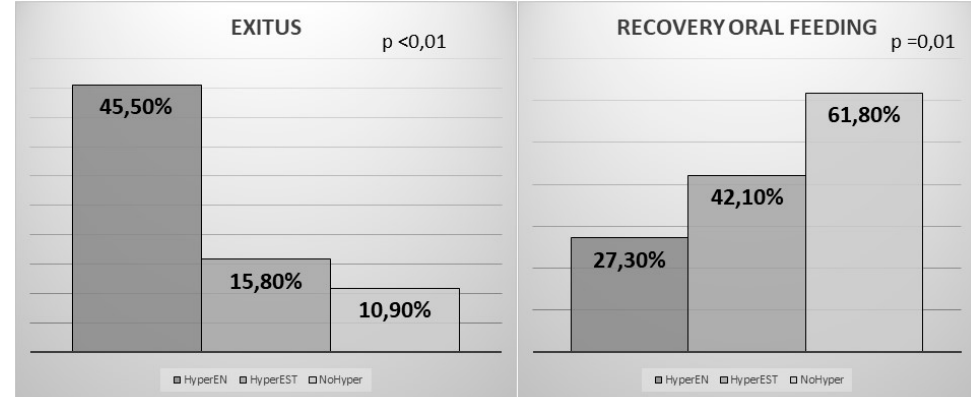
Figure 2. Di ff erences in the percentage of death and patients who recover the oral feeding in the group of hyperglycaemias associated with enteral nutrition (HyperEN), the group that developed hyperglycaemia of stress (HyperEST), and the one that did not develop hyperglycaemia (NoHyper). The di ff erences in the Rankin scale according to the development of hyperglycaemia are shown in Figure